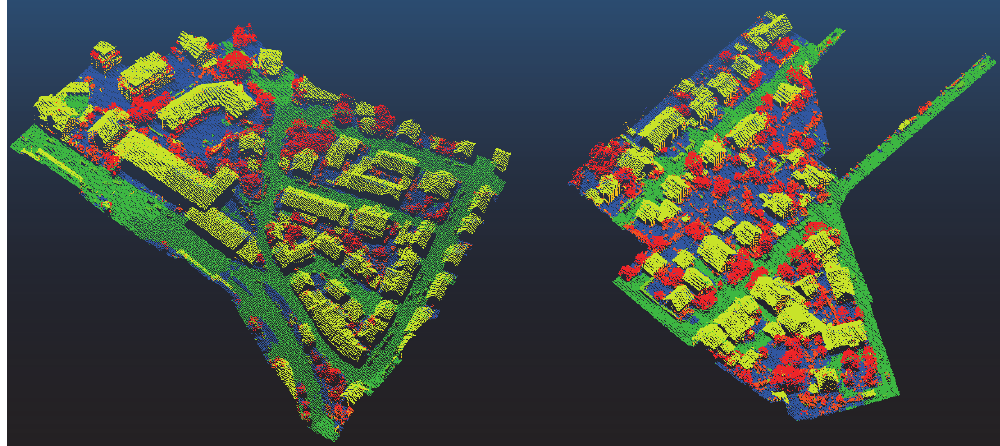
Figure 4. The classification result of the eigenentropy based method, the color encoding shows the assigned semantic class